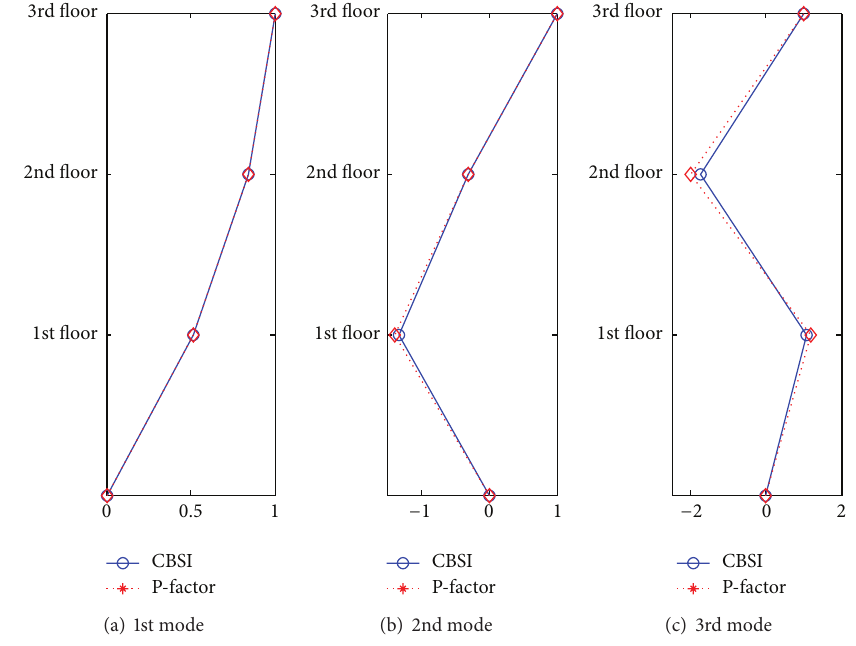
Figure 15: Mode shape